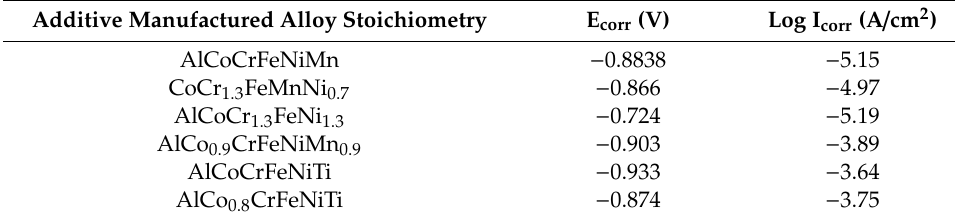
Table 1. List of shortlisted HEAs and associated potentiodynamic scan parameters for corrosion